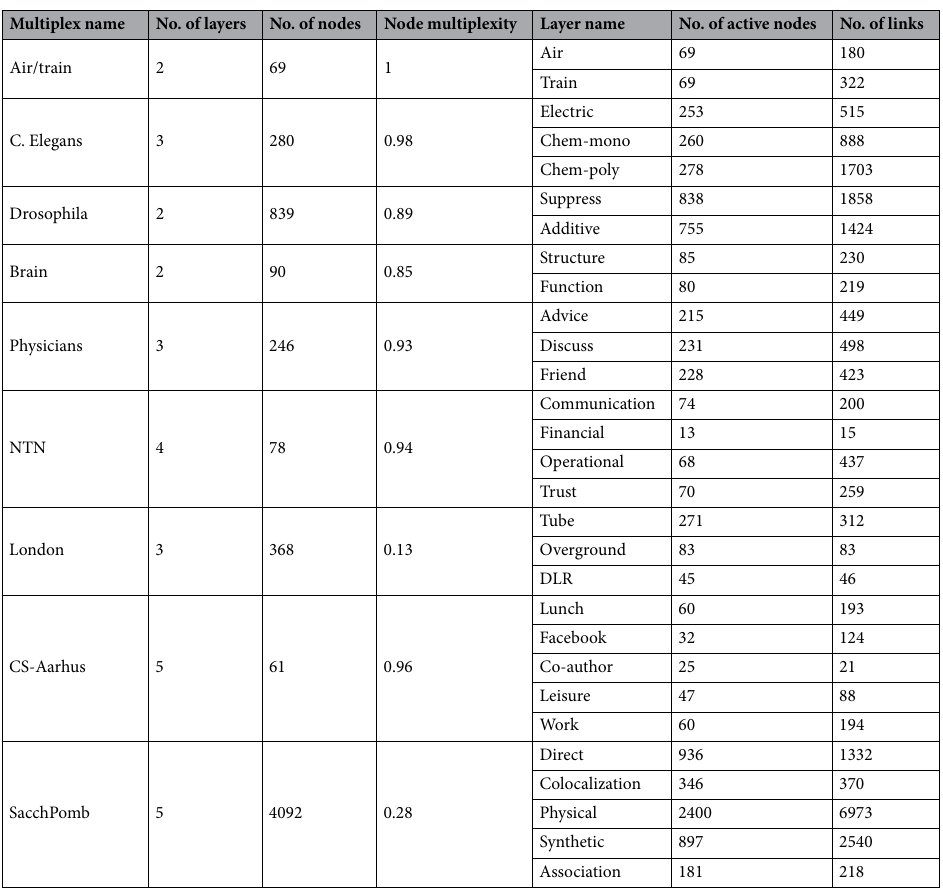
Table 1. Basic characteristics of multiplex networks used in